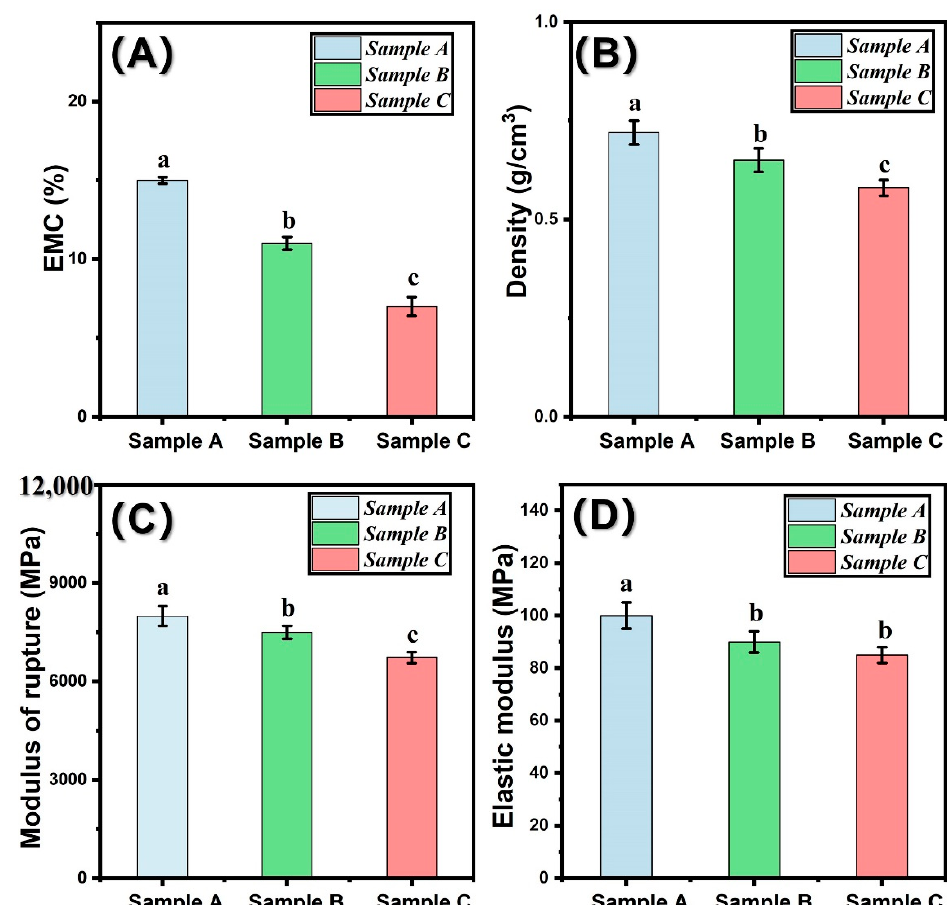
Figure 5. Physical properties of untreated, pressure-steam treated bamboo samples: ( A ) EMC; ( B ) Density; ( C ) modulus of rupture; ( D ) Elastic modulus. Significant difference between heat treatment groups ( p < 0.05) were presented by different small letters. The error bar in the picture represents the standard deviation.